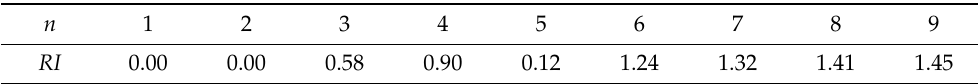
Table 3. Values of the average random consistency index.